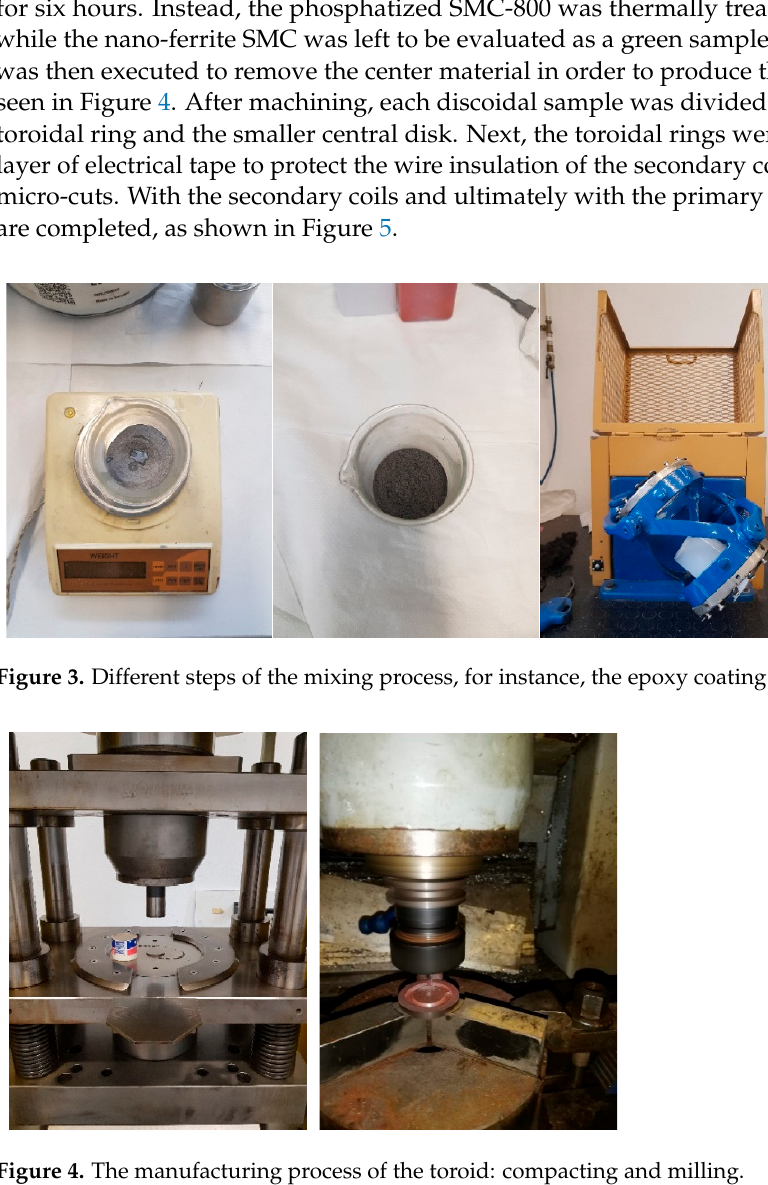
Figure 5. Toroid sample preparation for the test: winding process and test setup. Figure 6. Rod sample preparation for the test: winding process and size. Choosing the suitable materials to perform a comparison was a challenging task, which started from the considerations of the properties of a ring sample made from a part of a commercial SMC inductor. After having analyzed the properties of the commercial SMC, other materials were designed and made in order to obtain two main characteristics: a high resistivity value (high-insulating material content, and a metal oxide added) and better magnetic and energetic behavior (good initial and maximum magnetic permeability, far saturation, and good energetic properties). In summary, the chosen materials shared common properties: • Two of them contain the same weight percentage as the binder but different binder materials—see the above considerations on this constant weight ratio comparison. • Two of them contain the same binder material but in different percentages.